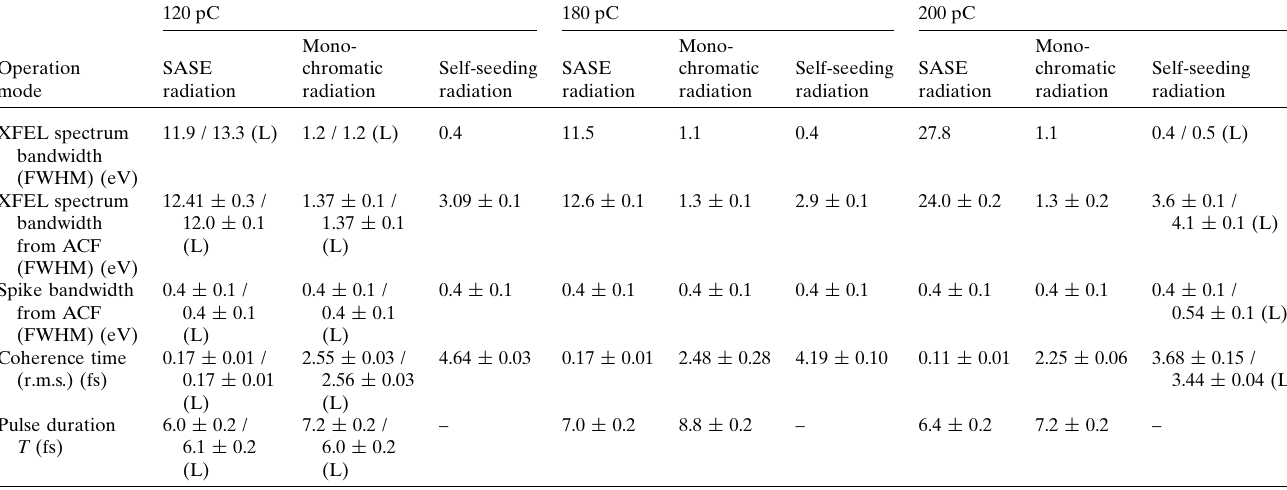
Table 1 Results of the analysis in the spectral domain for the 120, 180 and 200 pC bunch charges used in the experiment. The XFEL spectrum bandwidth was obtained directly from the averaged spectrum of all pulses in each operation condition. Analysis of the autocorrelation function (ACF) was performed using equation (6) that provided the intrinsic XFEL spectrum bandwidth as well as the spike bandwidth. Coherence times were estimated from equation (5) assuming that the average spectrum is fitted by two Gaussian functions. Pulse duration was obtained by fitting the central part of the second-order correlation function g in ( (cid:2) ! ) in equation (9). The values of different parameters measured in the linear mode of operation, indicated as (L), are also provided.